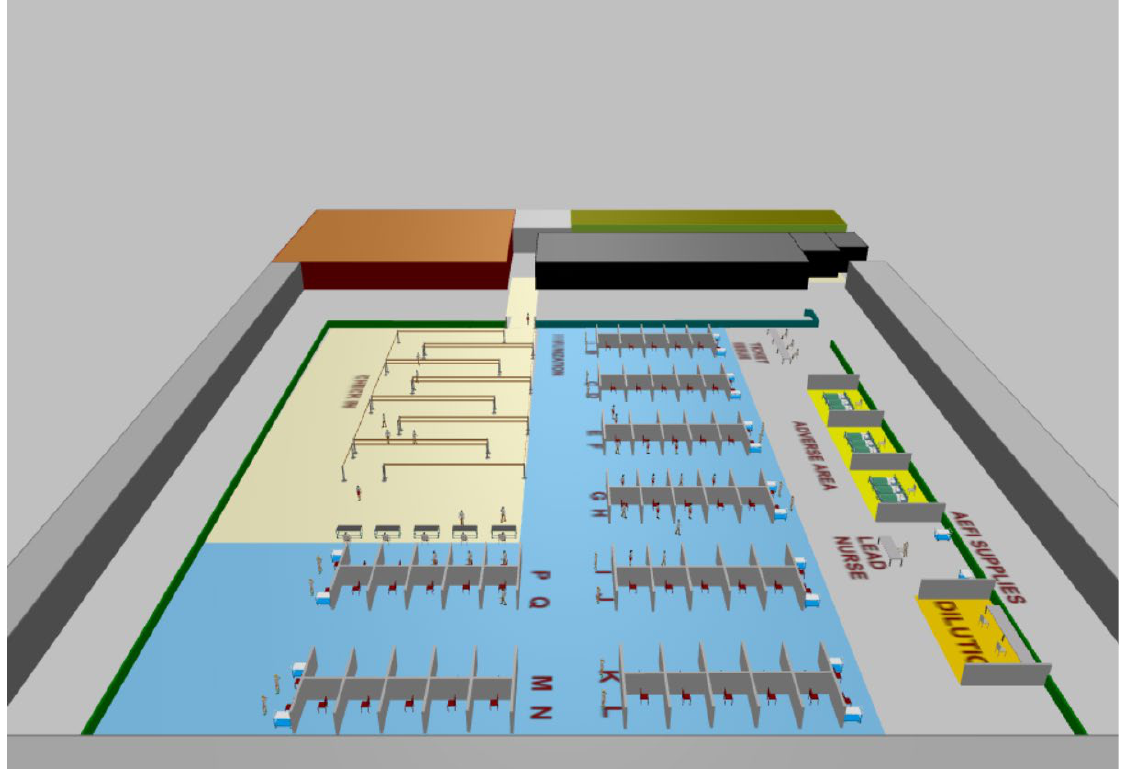
Figure 3. 3D physical layout of a hockey hub vaccination clinic in three